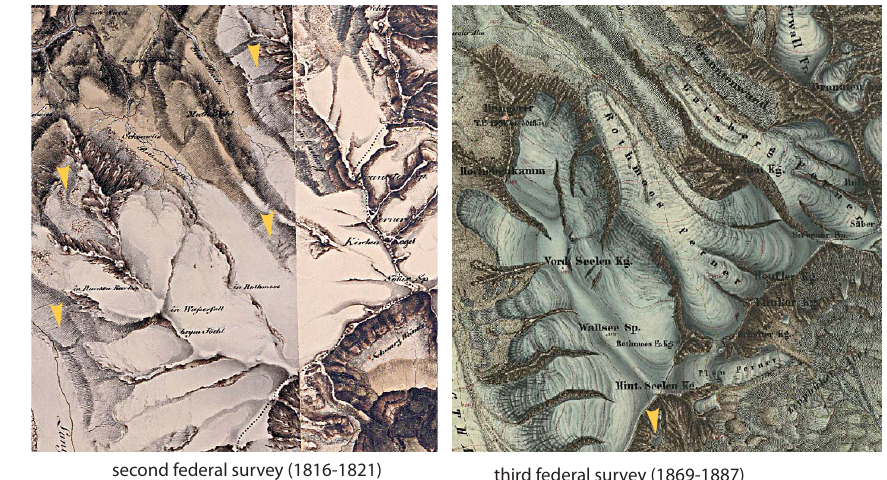
Figure 12. Federal maps of the second and third federal survey (before and after the LIA maximum) show uncertainties in differentiation of snow, firn and glacier (arrows) but give some general impression on LIA